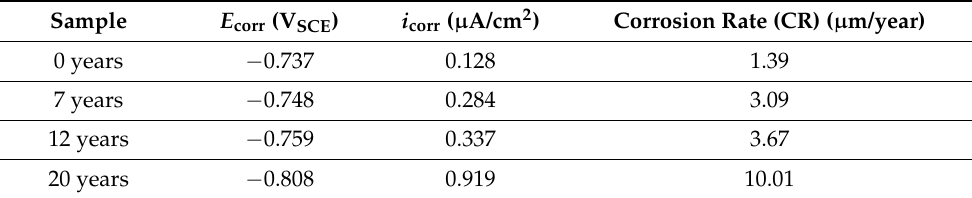
Table 4. Corresponding electrochemical corrosion parameters of the different samples obtained from Figure 14b.